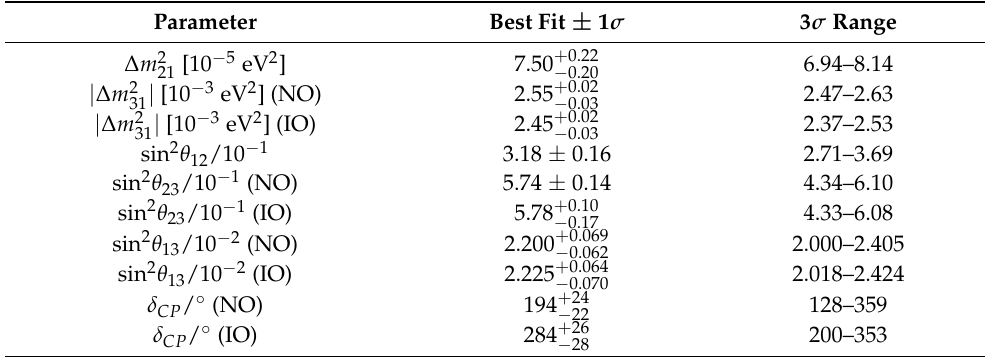
Table 1. Determination of the three-flavour neutrino oscillation parameters from a global fit to current neutrino oscillation measurements